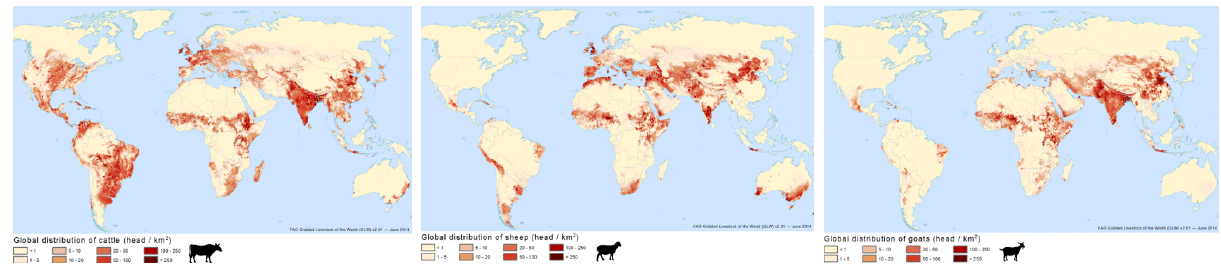
Figure 2. Global land cover shown with 1992–2018 composite information from CCI-LC maps (ESA CCI, 2020).